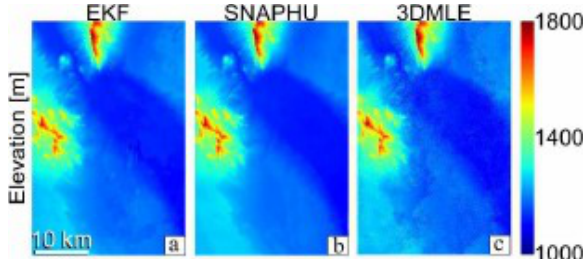
Figure 4: Estimated elevations using: a) EKF b) unwrapped using SNAPHU and weighted averaged c) unwrapped using 3D-Maximum Likelihood Estimator.